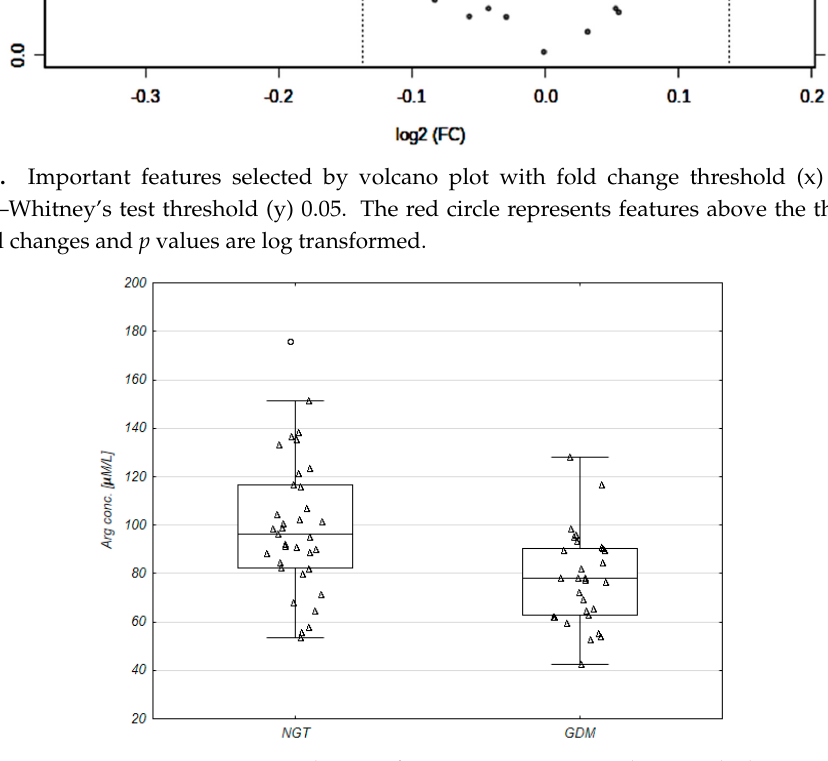
Figure 2. Arginine concentration in plasma of pregnant women with normal glucose tolerance (NGT; n = 35) and gestational diabetes mellitus (GDM; n = 29). Row data shown as triangular points. Boxes represent the median and interquartile range (25–75%), whiskers—non-outlier range, and circles—outliers.